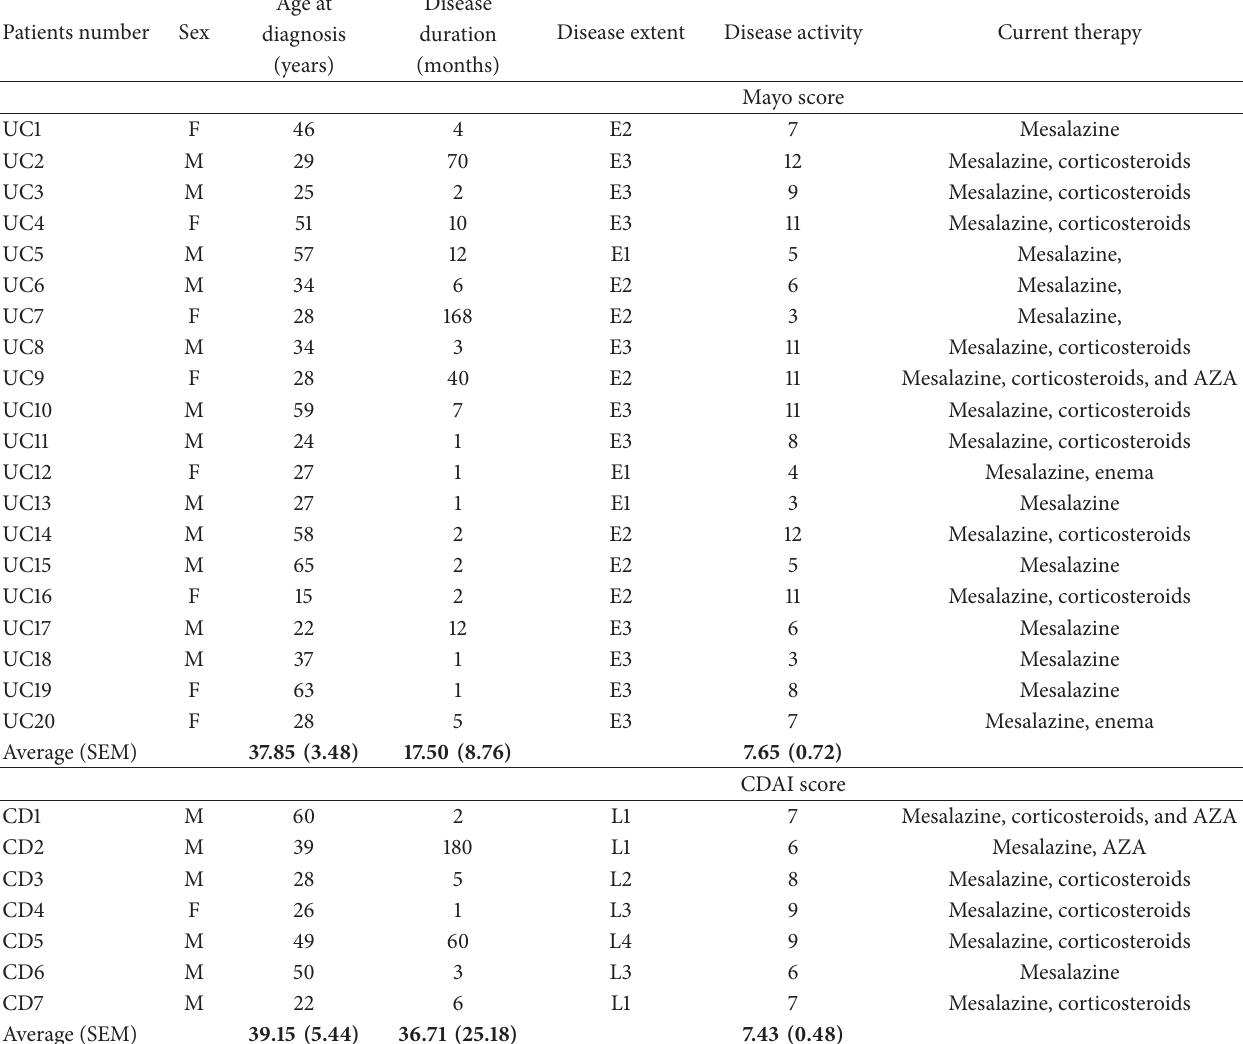
Table 1: Demographic and clinical characteristics of IBD